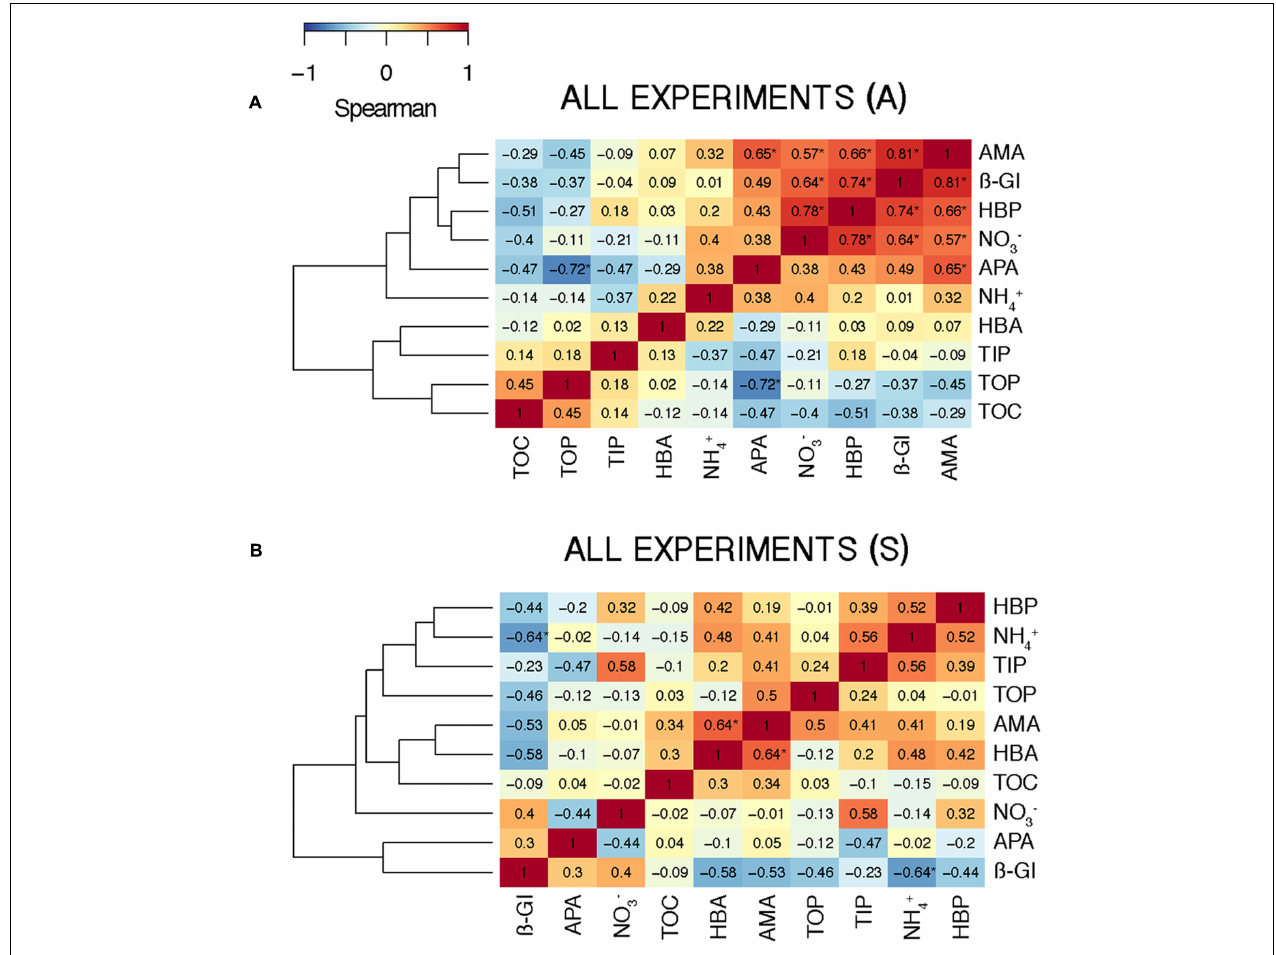
FIGURE 8 | Heat map showing the Spearman’s ρ coefficient between the biogeochemical variables considering (A) the A ( N = 14) and (B) the S ( N = 10) samples from all the experiments. Significant correlations ( p < 0.05) are indicated with an asterisk ( ∗